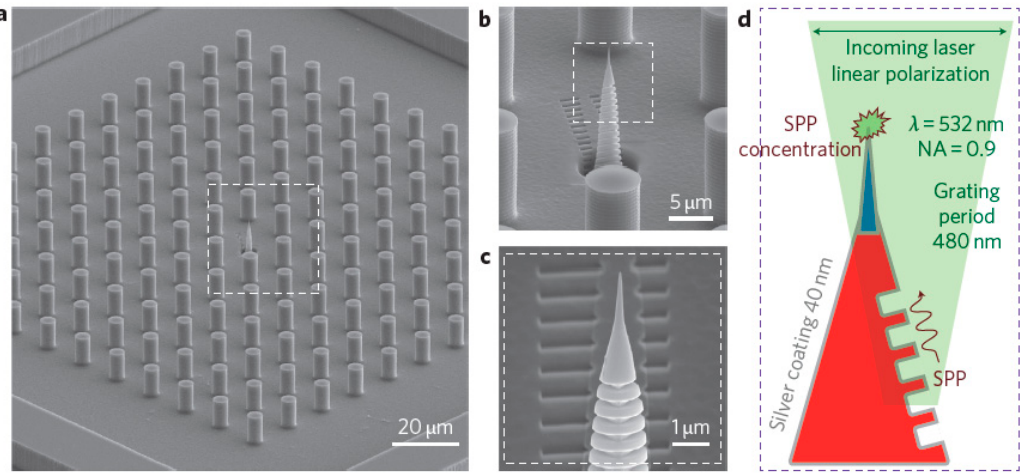
Figure 36. ( a ) SEM image of the super-hydrophobic structure with the nanotip in the center; when a drop of solution is deposited on this device, the high contact angle between the super-hydrophobic structure and the drop causes the analyte to concentrate on the nanotip during the evaporation process; ( b , c ) detailed SEM images of the nanotip; ( d ) a laser illuminates the nanotip generating a surface plasmon that propagates upwards and concentrates at the top of the nanotip. The large electromagnetic field produced allows the SERS detection of the analyte. Reproduced with permission from De Angelis et al. [352], (2011) Macmillan Publishers Limited.